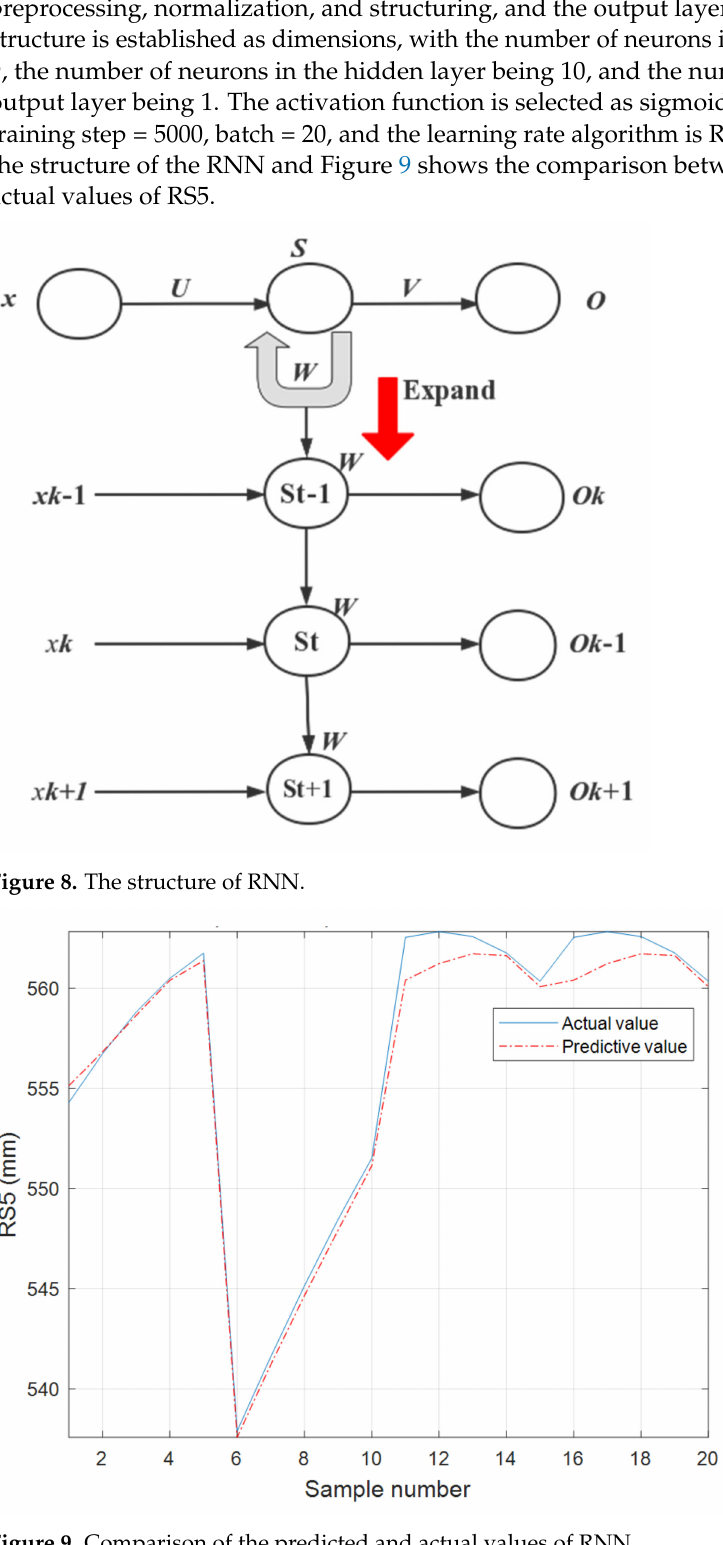
Figure 9. Comparison of the predicted and actual values of